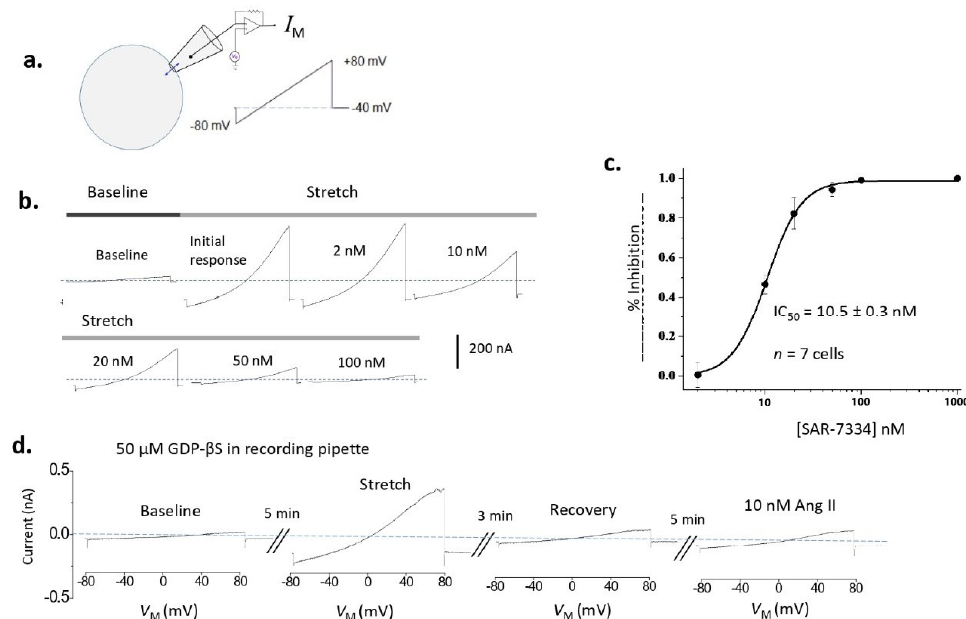
Figure 1. Activation of TRPC6 channels in podocytes by hypoosmotic stretch of the plasma membrane. Membrane stretch was evoked by superfusion of an extracellular saline that is 70% as concentrated as that used when whole-cell contact is initiated (Baseline). ( a ) Whole-cell recording configuration and ramp voltage command to characterize cationic currents. Details of recording conditions, including the voltage-clamp protocol, and the composition of pipette and extracellular solutions are described in [23]. ( b ) Cationic currents evoked by membrane stretch are progressively blocked by increasing concentrations of the selective TRPC6 inhibitor SAR-7334. This recording was made from